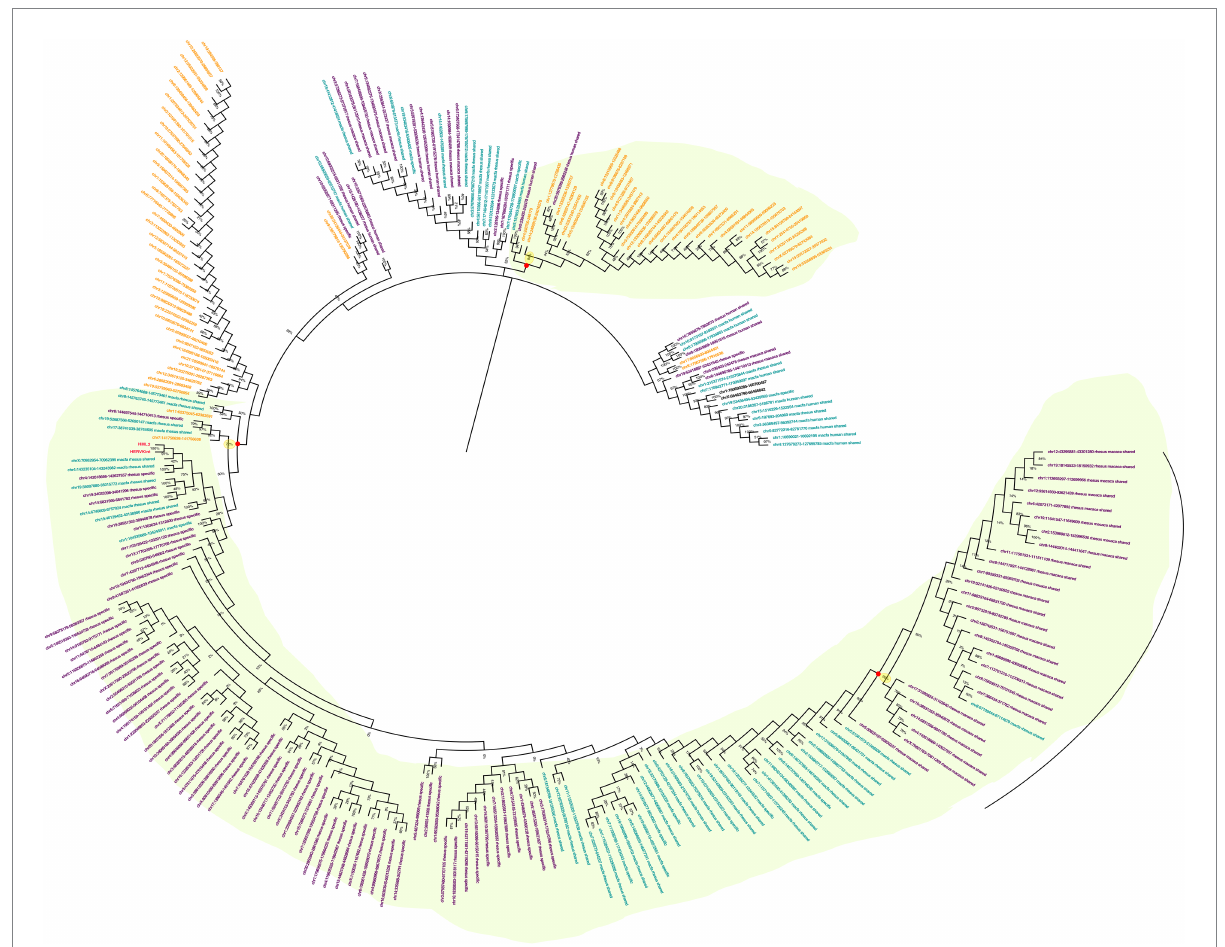
FIGURE 1 Phylogeny of HML2 integrations in Humans, Macaca fascicularis and Macaca mulatta. Phylogenetic trees generated for full-length or near full- length sequences for all the three species using Neighbor-joining method with a bootstrap of 500 replicates in MEGA 11 software. The human sequences are indicated in yellow, M. fascicularis in cyan, and M. mulatta in magenta. Supported phylogenetic clusters are highlighted with a light green